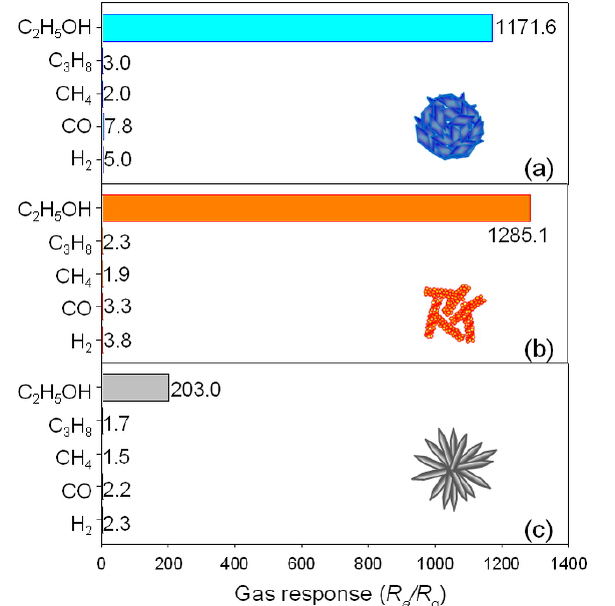
Figure 8. Gas responses to 100 ppm C ( b ) NR sensor; and ( c ) H-NR sensor at 400 °